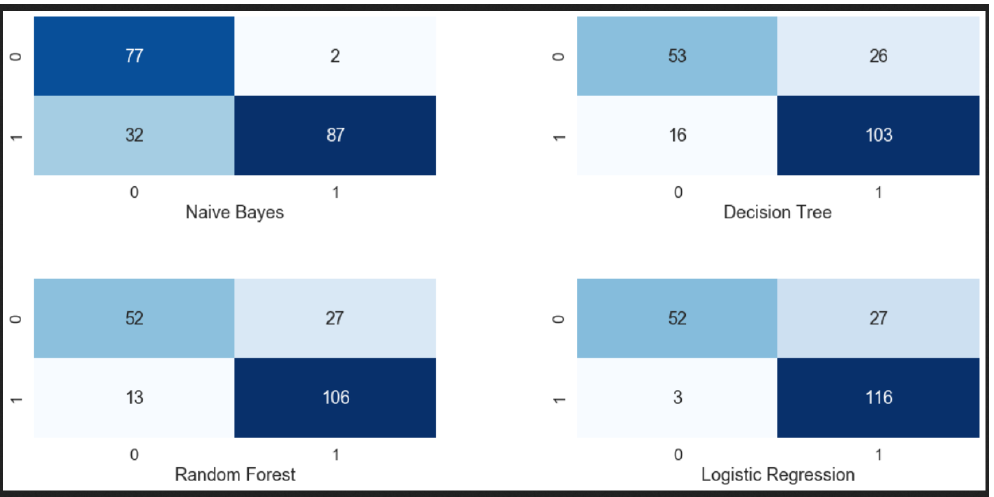
Figure 7. Confusion matrix.